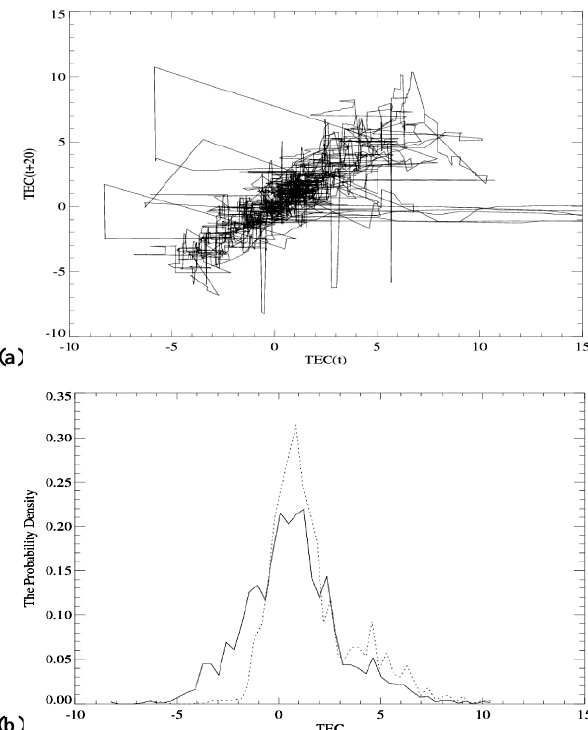
Fig. 2. Plots of (a) delay representation for the detrended time series of TEC with m = 8 and τ = 20 and (b) probability density for the first half of time series of detrended TEC (continuous line) and that of second half of the series (dashed line) measured at